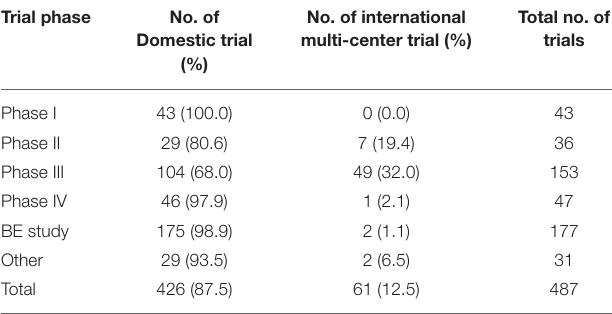
TABLE 3 | Different trial phase scope.